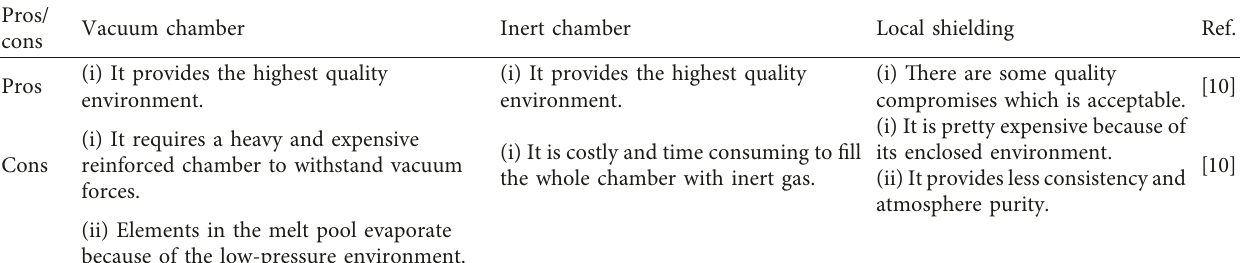
Figure 4: Shielding medium. Table 1: Pros and cons involving the use of these shielding